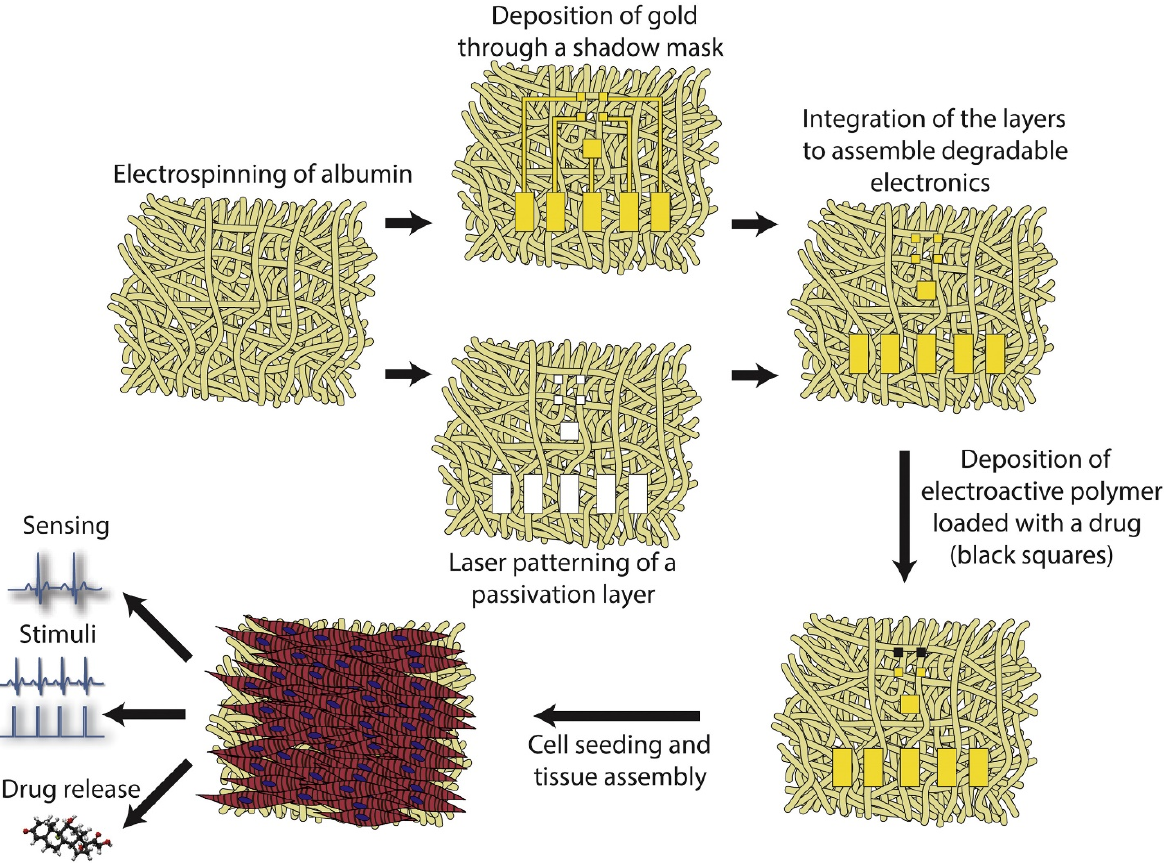
Figure 7. Schematic representation of the advanced scaffold developed by Feiner et al. Electrospun albumin creates two thick mats: the first is covered with shadow masks and 600 nm thick Au electrodes are evaporated onto it, and the second mat is used as a passivation layer. The layers are stuck together using an ECM-based hydrogel as an adhesive. Next, a layer of polypyrrole loaded with dexamethasone is deposited onto selected electrodes. Neonatal rat ventricular cardiomyocytes are seeded onto the device that permits further organization into functional cardiac tissue. With the aid of an external amplifier, extracellular signals may be recorded from the tissue, and stimuli may be delivered to the device for pacing and drug release. Adapted from [49] . 4. Summative Discussion and Future Perspectives To address the limitations of current cardiac injury treatments, extensive research has been noted in developing biomaterial-based strategies. Special focus was observed on us- ing various natural and synthetic polymeric materials to create delivery platforms for dif- ferent cells and bioactive molecules relevant to cardiac tissue engineering and regenera- tion. Recent research efforts have materialized into a number of cardiac patches, injectable hydrogels, extracellular vesicle-based therapies, and advanced scaffolds that showed promising results when tested in vitro and in vivo. Nonetheless, the proposed innovative treatment strategies have not yet reached the stage of clinical testing, except for a few studies (Table 2). Specifically, scientists have translated pre-clinical research to human testing of several biomaterial approaches, including VentriGel [98], CorMatrix-ECM [99], PeriCord [100], and epicardial atrial appendage micrograft (AAM) patch [101].